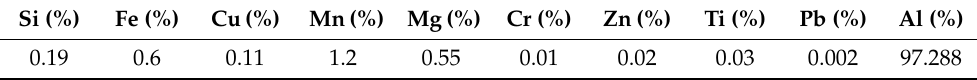
Table 2. Chemical composition of Al substrate